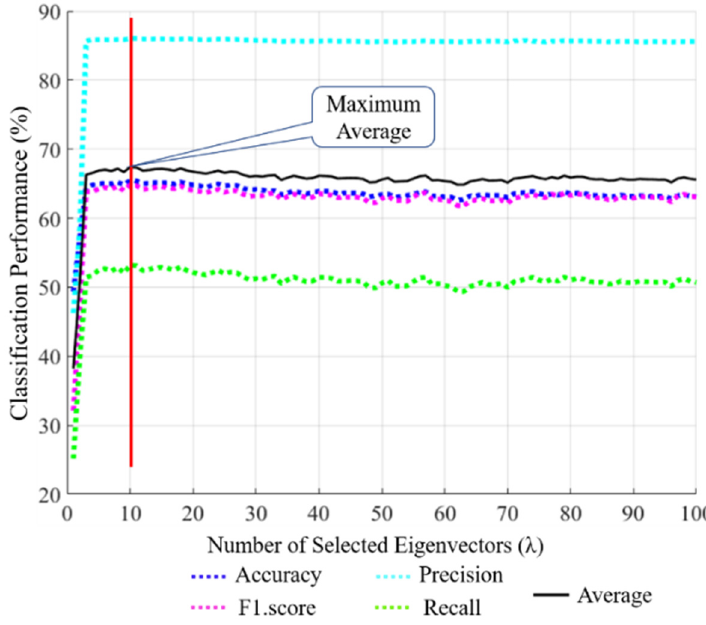
Figure 9. PCA-based performance for different numbers of eigenvectors ( λ = 1, 2, 3, . . . ,100). Table 7. Performance comparisons of our proposed SCN using a PCA and a K-NN (unit: %). Performance without a PCA (our SCN) Performance with PCA ( λ = 10) + K-NN Fold Accuracy F1-Score 10-Fold Average